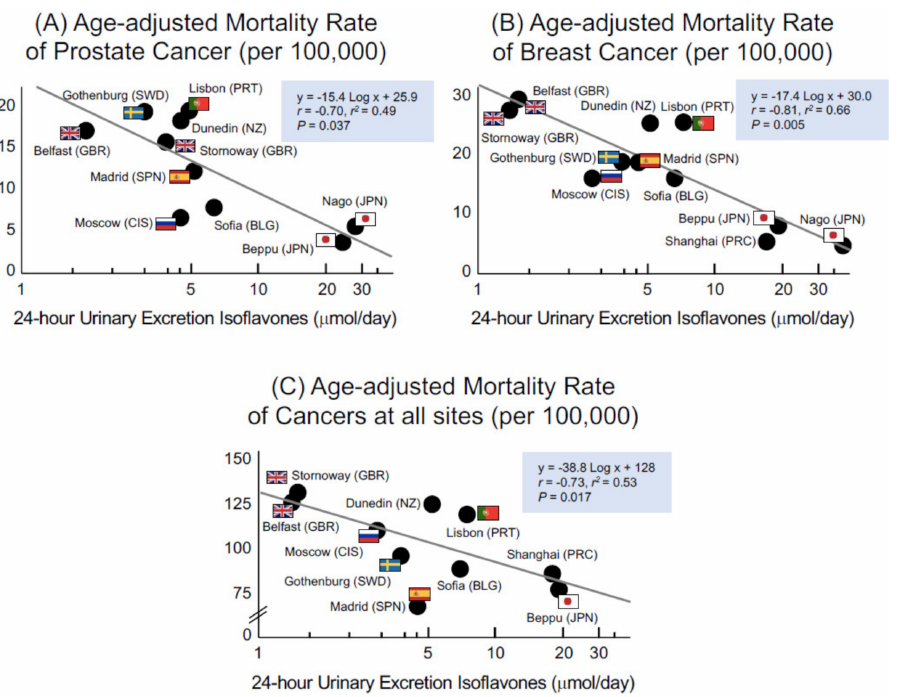
Figure 3. Relationship between 24 h urinary isoflavone excretion and age-adjusted mortality rates of PCa ( A ), BCa ( B ), and cancers at all sites ( C ) [41,42]. Each vertical axis represents age-adjusted mortality rate per 100,000